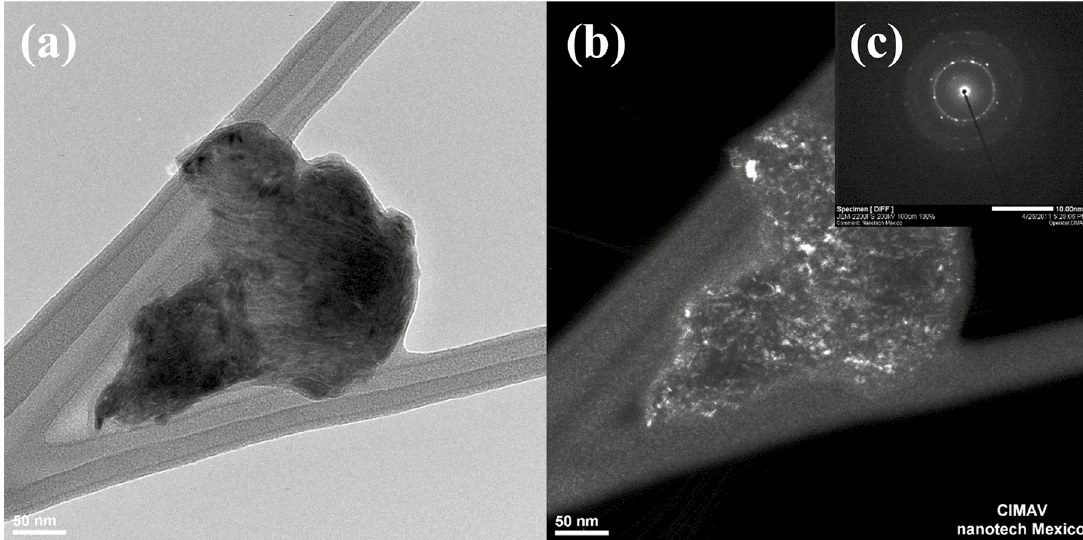
Figure 5: (a) Bright-field and (b) dark-field TEM images of NiCoAlFeCu alloy after 30 h milling as well as SAED pattern (c). aperture, and shows a crystalline size in nano-scale (less than 20 nm). In the other hand, fine polycrystalline signal (small points in fine rings) can be seen in the pattern of Figure